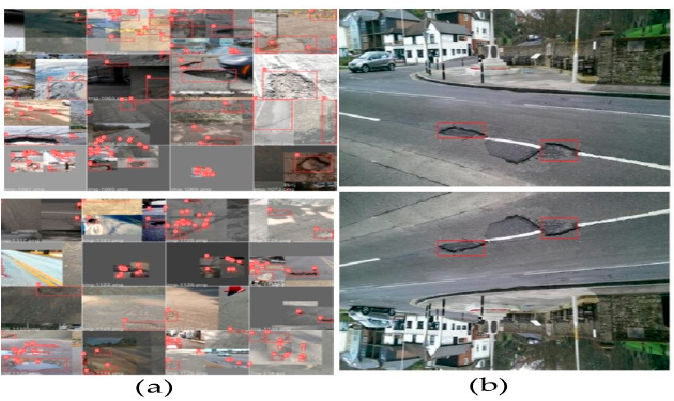
Figure 6. Data augmentations: ( a ) Mosaic YOLOv5, ( b ) Faster R-CNN.